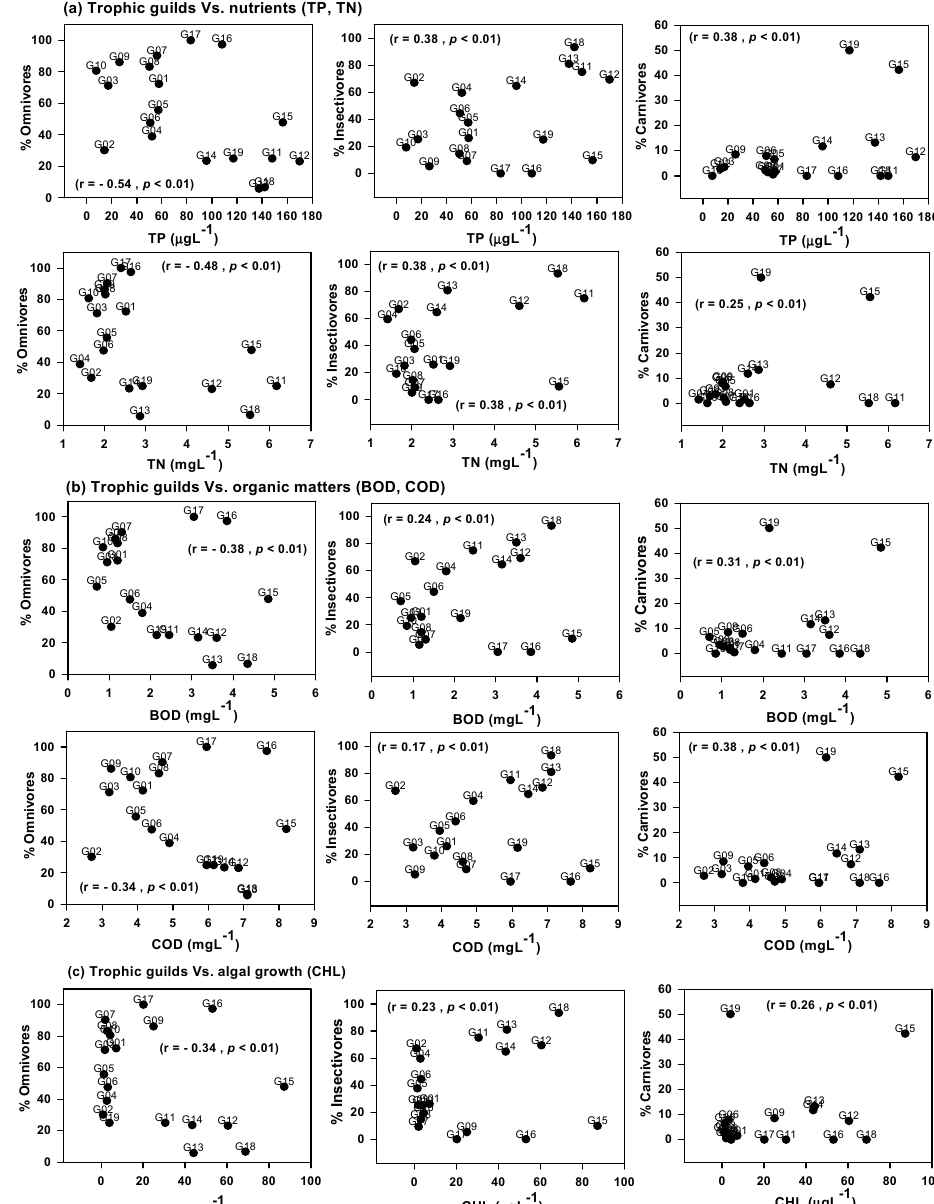
Figure 5. Trophic guild analysis with water quality factors (TN—total nitrogen, TP—total phosphorus, N:P ratios, BOD—biological oxygen demand, COD—chemical oxygen demand, CHL—chlorophyll).